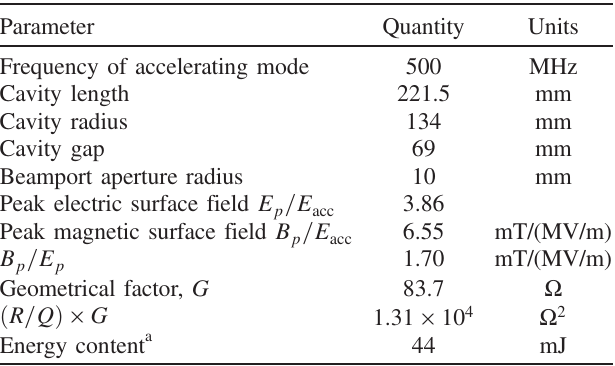
TABLE VII. Cavity and rf properties of the gun design. Set to ¼ 10 . 3 MV = m. operate at E acc